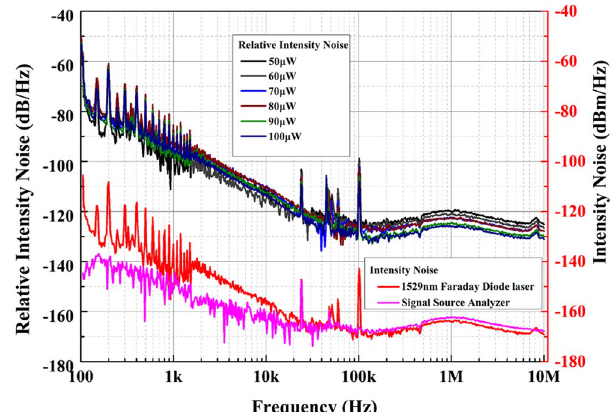
Figure 3. The two bottom colored lines refer to the electrical-domain intensity noise of the Faraday laser lasing on Rb 1529 nm transition (red curve) and signal source analyzer (pink curve). The six upper colored lines refer to measured relative intensity noise of the Faraday laser with different optical power.